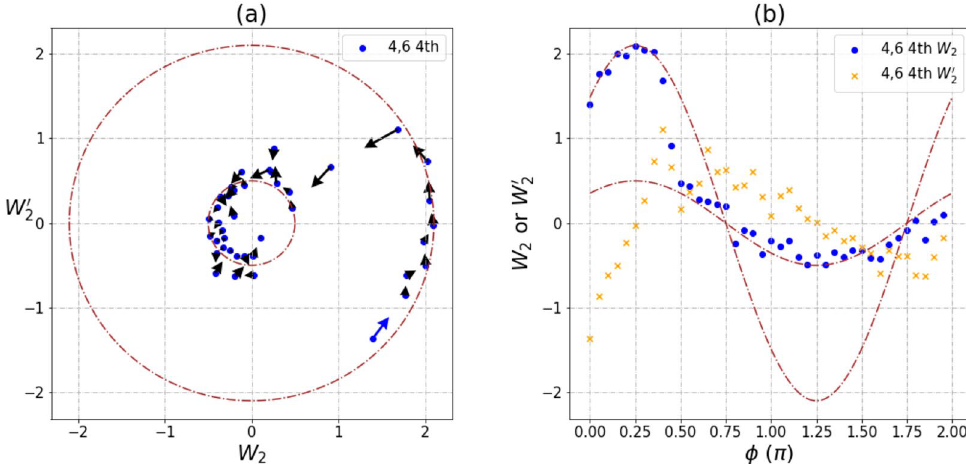
W ′ W 2 and 2 (cid:30) (cid:31) W 2 (cid:31) (cid:30) measurements of pair [4,6] at 4th run on IBM Rochester. Experimental shots are 1024. ( a ) The trajectory of (cid:30) (cid:31)